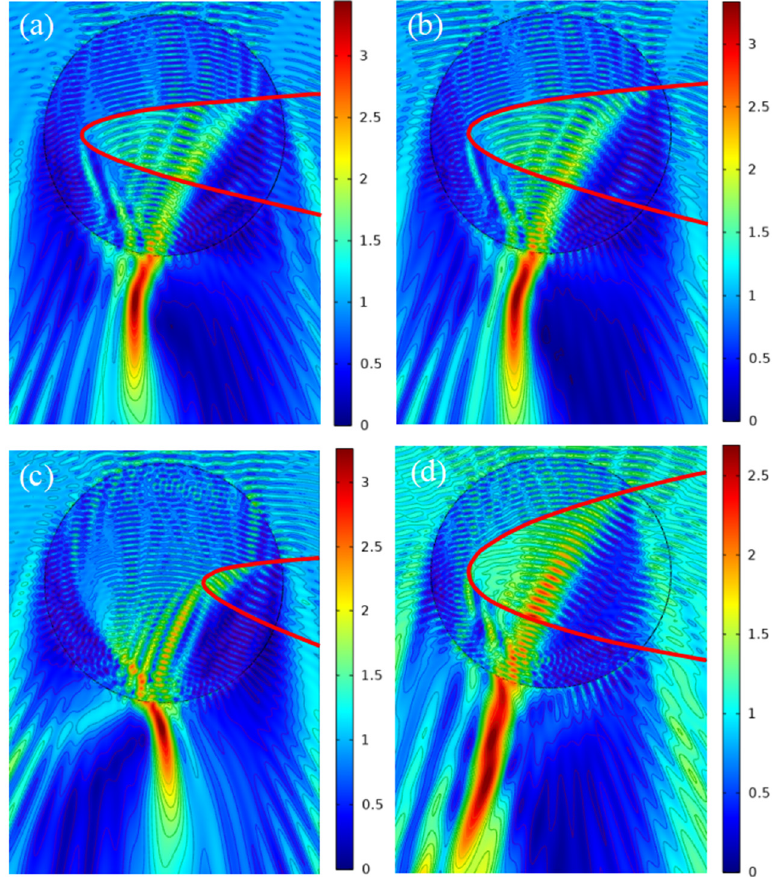
Figure 7. Distribution of electric field for different coefficients A , B , C and D . ( a ) A = 2.00, B = 3.00, C = − 9.00, and D = 0.33. ( b ) A = 1.44, B = 2.28, C = − 9.00, and D = 0.25. ( c ) A = 2.00, B = 3.00, C = − 4.50, and D = 0.67. ( d ) A = 0.67, B = − 0.35, C = − 9.00, and D = 0.04. Table 1. Comparison of the bending angle and the effective length of the PH between the proposed method and previous work.